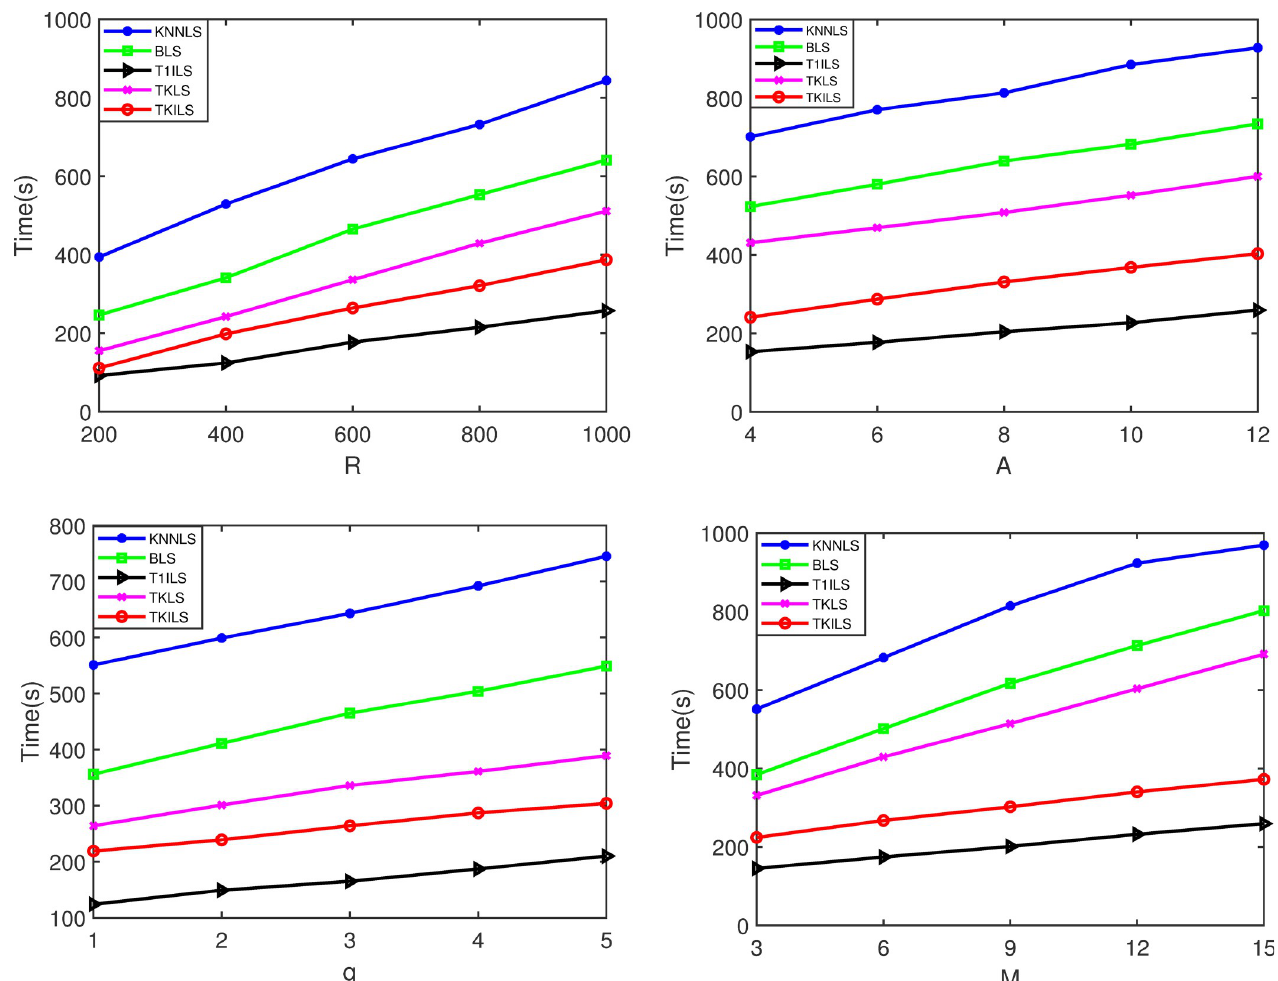
Fig 9. Time results on the real datasets. Note: Fig 9(A)–9(D) are the time results for varying | R |, | A |, | q | and | M | on the real datasets, respectively.